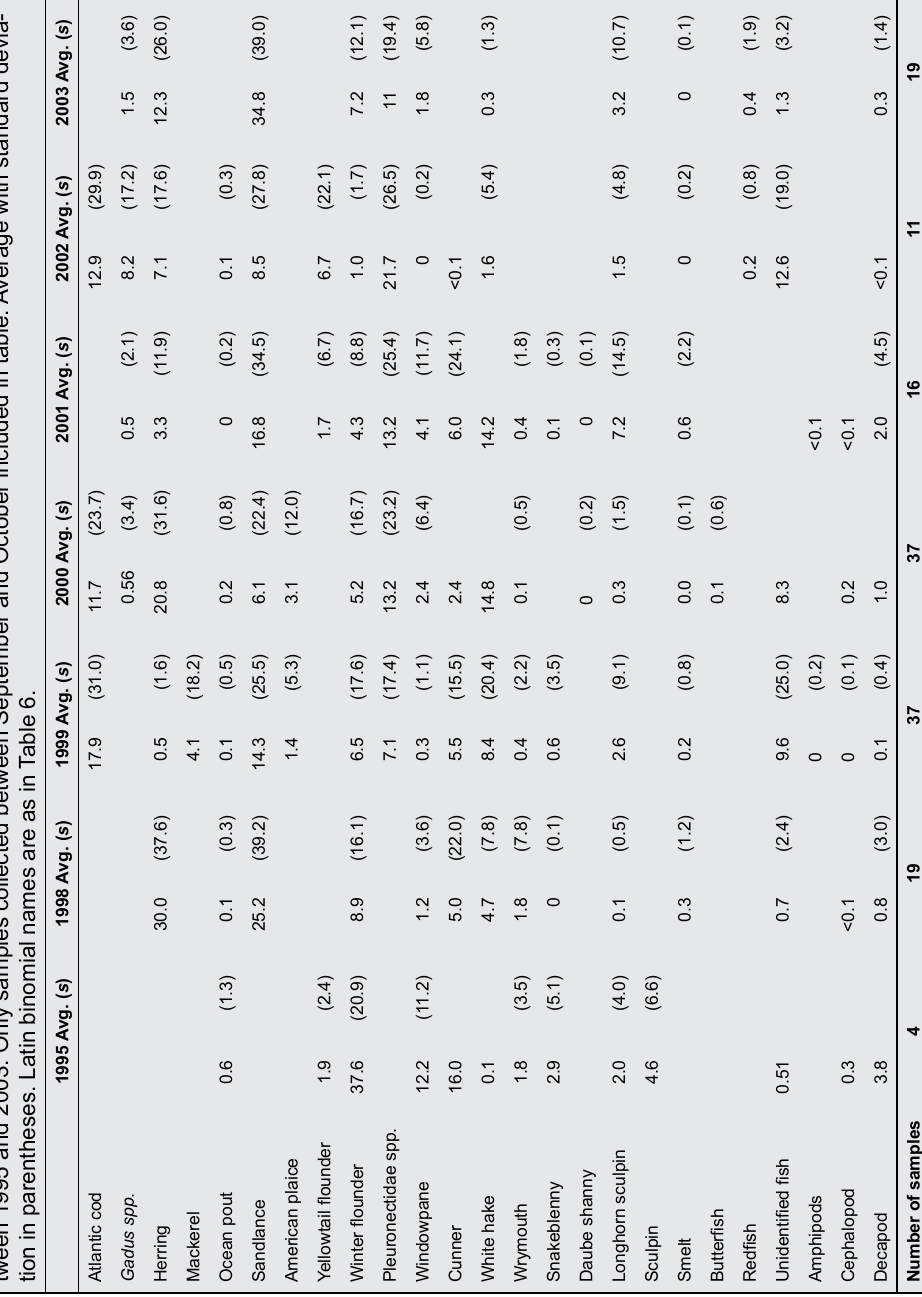
Grey seals in the North Atlantic and the